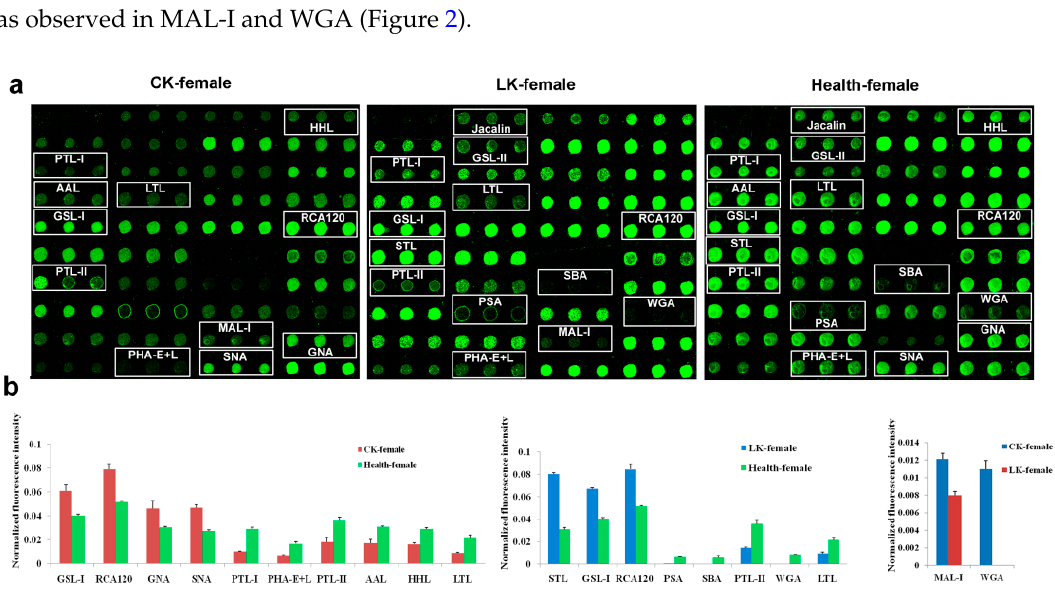
Figure 2. Female salivary glycoprotein glycosylation patterns were determined by the binding of Cy3- labeled protein to 37 different lectins using a lectin microarray. CK: CKD, LK: LKD and Health: normal control. ( a ) Profiles of Cy3-labeled salivary proteins from patients with CKD and LKD, and normal individuals bound to the lectin microarrays. The lectin microarrays revealed lectins that exhibited significant differences, which are marked with white frames; ( b ) Significant differences in the lectin levels among the three groups. The bars represent mean ± SD measured from three replicate spots of lectins.